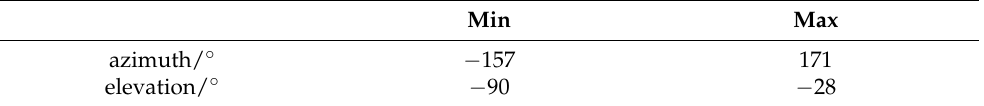
Table 2. Min and max azimuth and elevation values for six tags’ poses in the RTLS